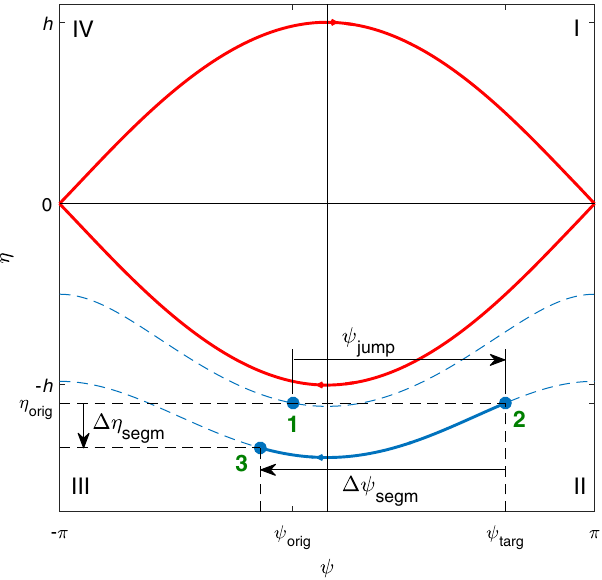
FIG. 4. The microbunch deceleration cycle as illustrated by the movement of the average particle outside the bucket. Position 1 corresponds to the starting point of a drift section, position 2 the end point of the same drift section, and position 3 the end point of the subsequent undulator